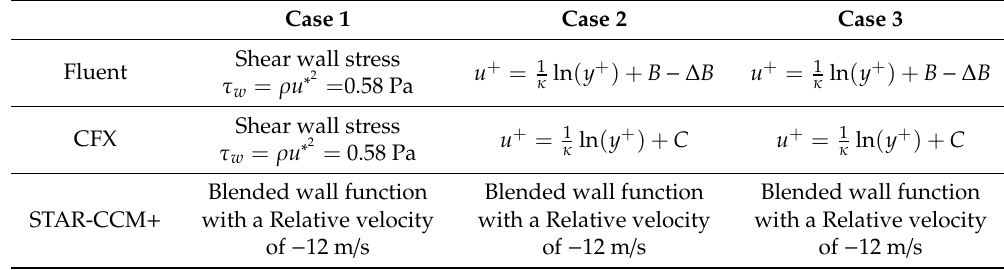
Table 4. Wall Boundary Conditions for Each Case Using the Di ff erent